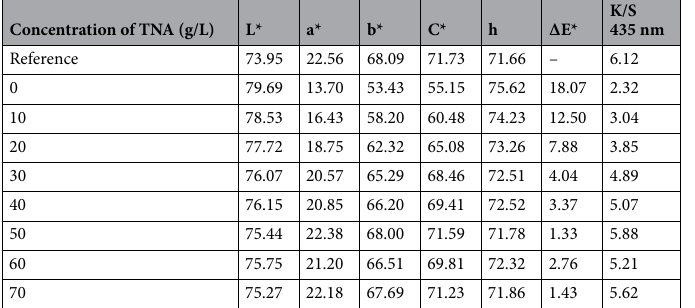
Table 2. The effect of TNA concentration on the color data using 2% owf reactive dye shade of RY 145. Reference: The dyed sample with conventional method using 50 g/L SS and 20 g/L SC.